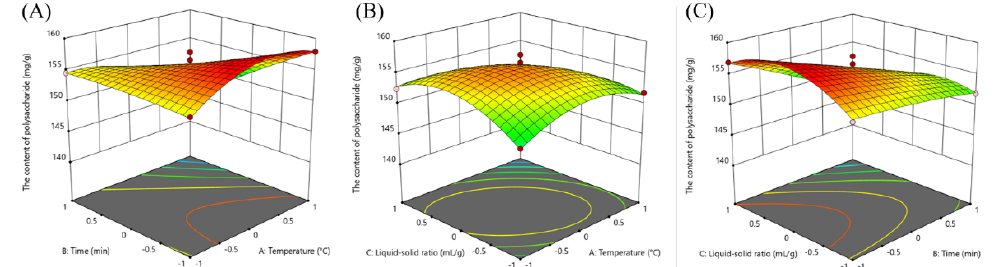
Figure 2. The response surface plots expressing the effect of extraction parameters on the yield of polysaccharides. ( A ) extraction temperature and extraction time; ( B ) extraction temperature and liquid-solid ratio; ( C ) extraction time and liquid-solid ratio. liquid-solid ratio; ( C ) extraction time and liquid-solid